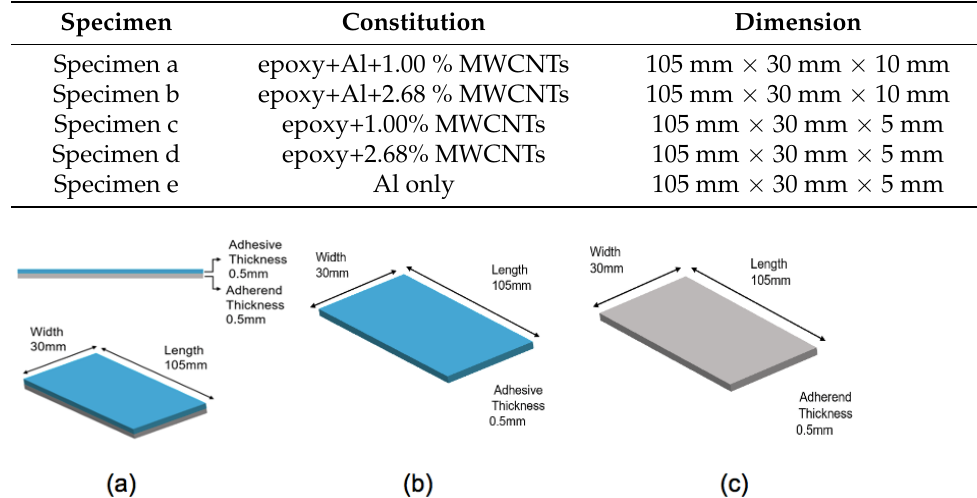
Table 1. List of specimens manufactured in the present study.